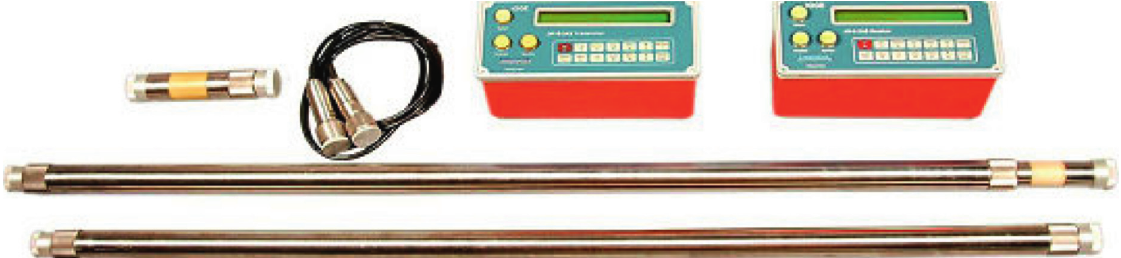
Figure 6: JW-6 underground high-frequency electromagnetic wave CT system.